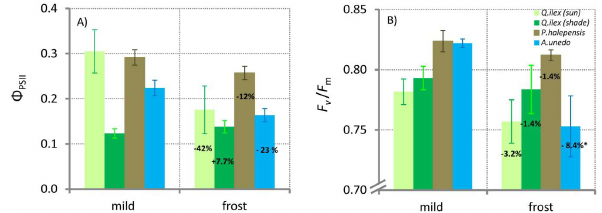
Figure 7. Bar plot of the effect of a sudden period of frost following a mild winter period on (a) the effective quantum yield of photosys- tem II ( 8 PSII ) and (b) the maximum efficiency of photosystem II ( F v /F m ) in sunlit leaves of Q. ilex (light green bar), in shaded leaves of Q. ilex (dark green bar), P. halepensis (beige bar) and A. unedo (blue bar). The error bars represent the standard error, and the per- centages indicate the change between periods where significance is indicated with an asterisk ( P ≤ 0 . 05).